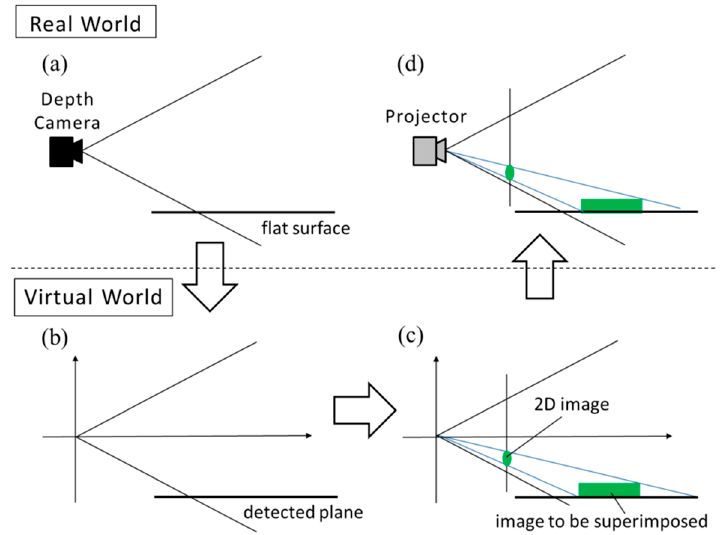
Figure 3. Superimposing an image on a flat surface. The image looks to have the proper size and shape on a flat